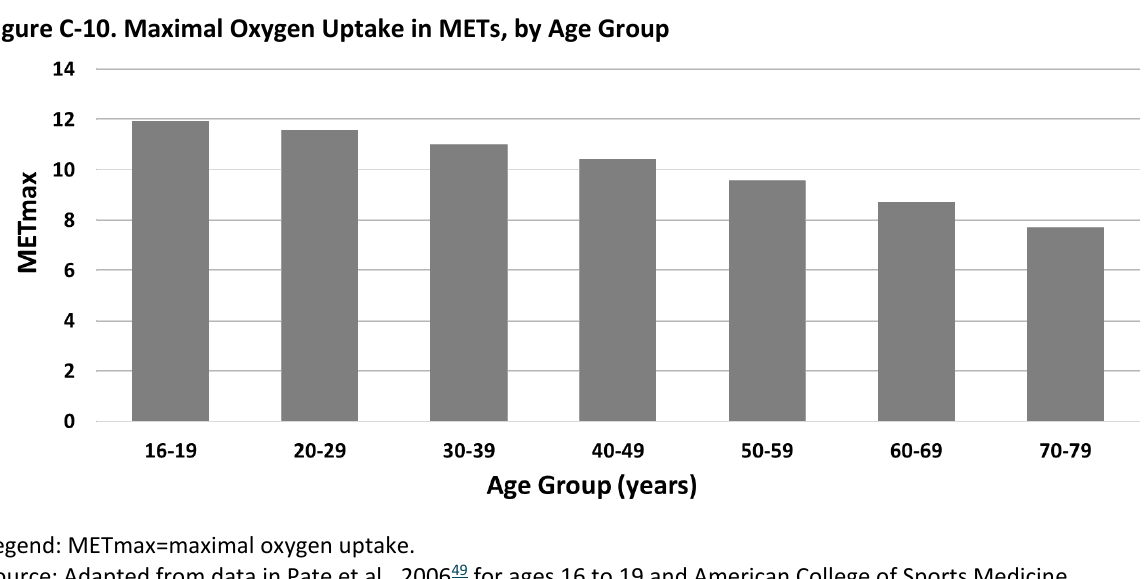
Figure C-10. Maximal Oxygen Uptake in METs, by Age Group